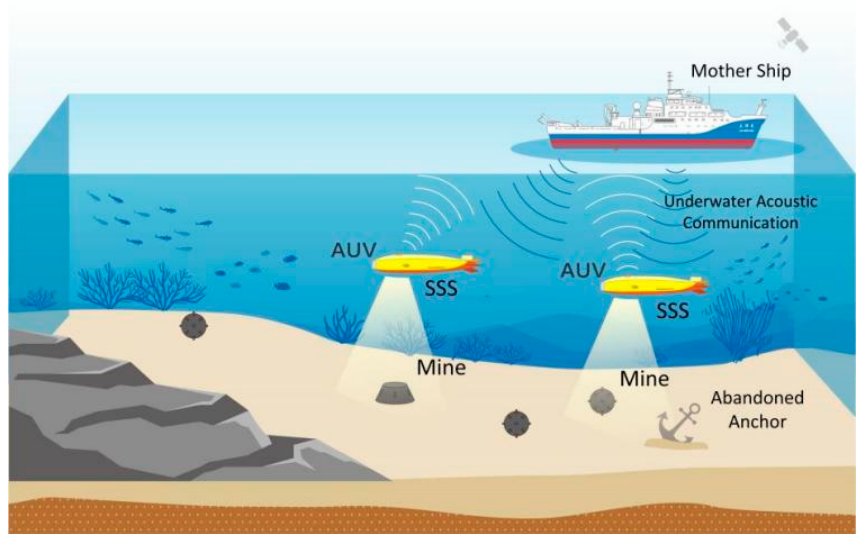
Figure 1. Diagram of the real-time AUV-based SSS underwater-target detection system.